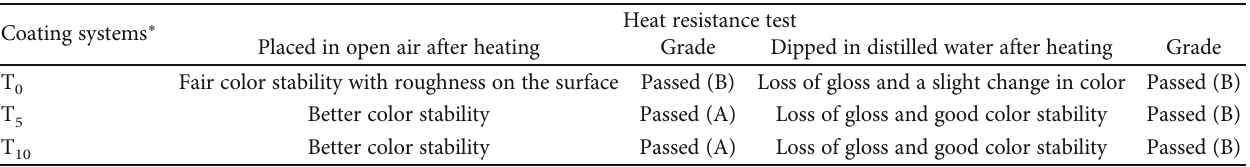
Table 4: Results of heat resistance testing of the virgin epoxy coating and titanium-embedded epoxy coatings after 24 hours of heating followed by open-air exposure and dipping in distilled water as per ASTM D2485. Coating systems ∗